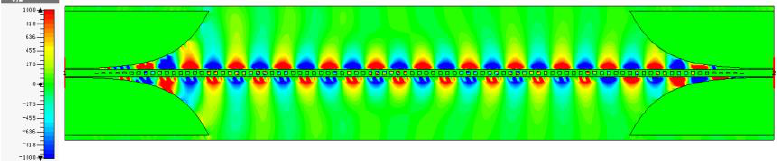
Figure 3. Simulated E-field magnitude distribution at 10 GHz.